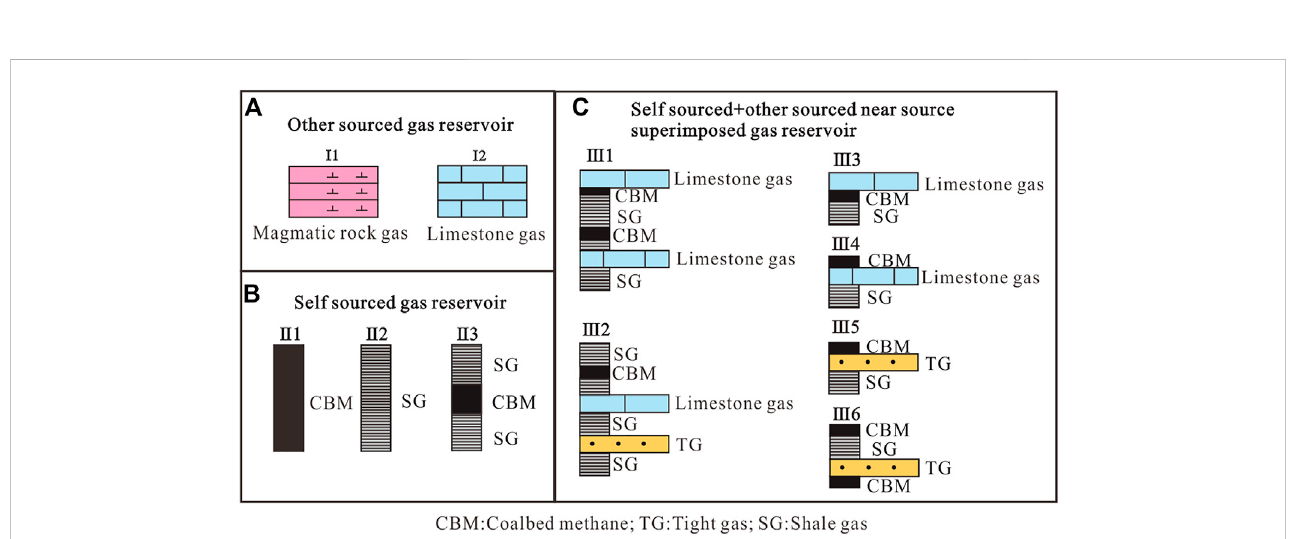
FIGURE 8 Three types of CMG reservoirs, namely, other-source gas reservoirs (A) , self-sourced gas reservoirs (B) and self-sourced+other-source near-source superimposed gas reservoirs (C) .